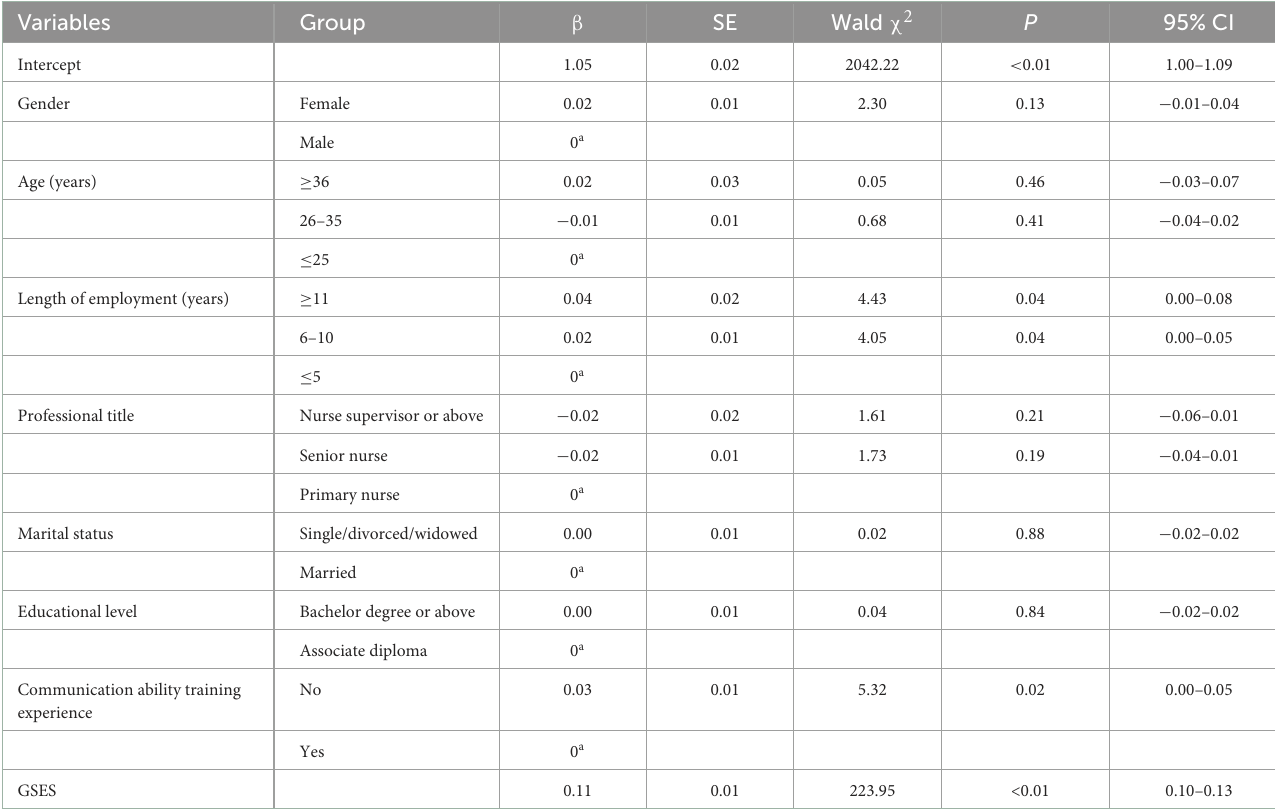
TABLE 4 Generalized linear model for factors associated with ED nurses NCAAPS ( N = 679).